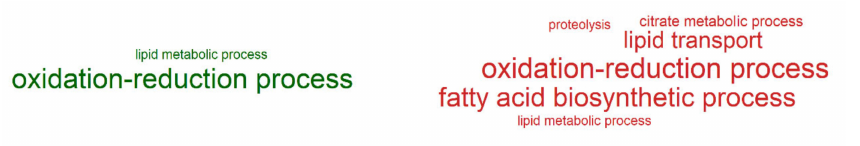
Figure 3. GO analysis of terms enriched in PC2 with positive loadings/positively correlated with PC2 (left in green) and negative loadings/negatively correlated with PC2 (right in red). Font sizes of individual terms are scaled by the negative natural logarithm of the p -value of the Kolmogorov- Smirnov